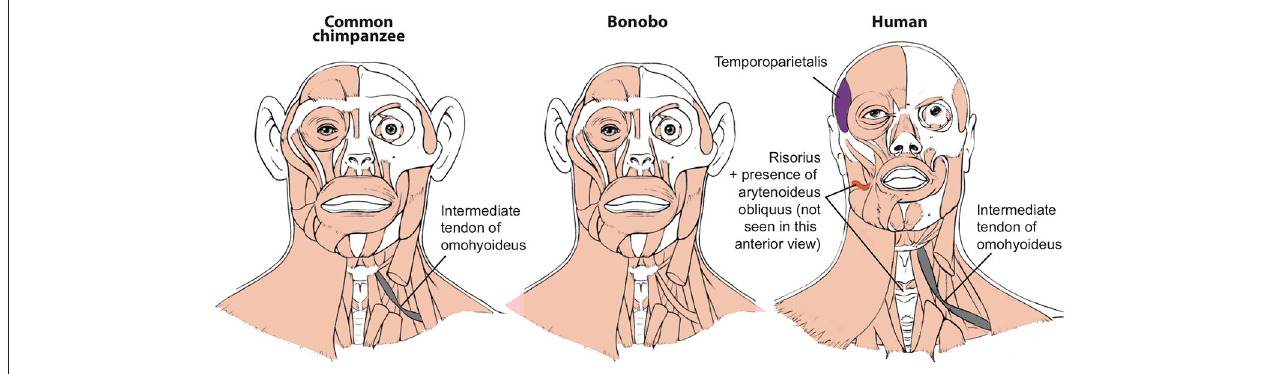
FIGURE 1 | Differences between head muscles of common chimps, bonobos, and humans, based and modified from Diogo et al. (2017b). There are no major consistent differences concerning the presence/absence of muscles in adult common chimps (left) and bonobos (center) , the only minor difference (shown in gray in the common chimp scheme) being that the omohyoideus has no intermediate tendon in bonobos, contrary to common chimps (and humans). In contrast, there are many differences between bonobos and humans (right) concerning the presence/absence of muscles in the normal phenotype (shown in colors and/or with labels in the human scheme). Modified from Diogo et al. (2017b); © Diogo has copyright of these